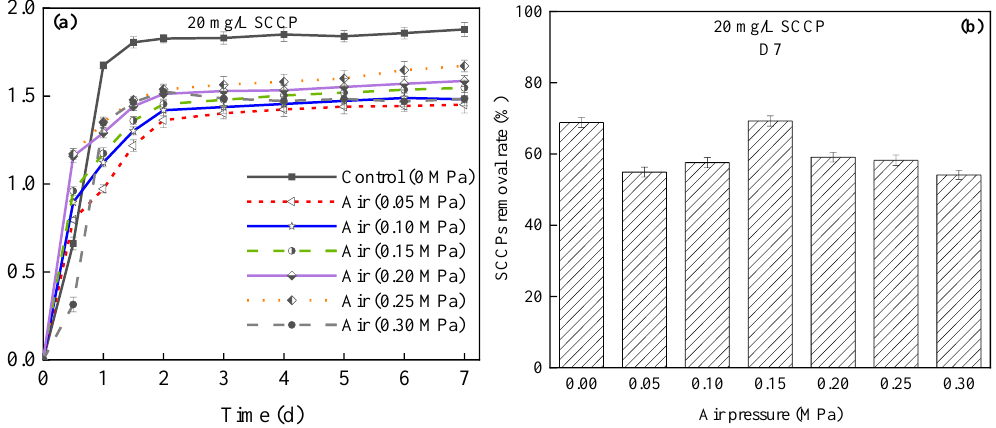
Figure 3. Relationship between different air oxygen pressures and ( a ) the growth of E. coli strain 2;